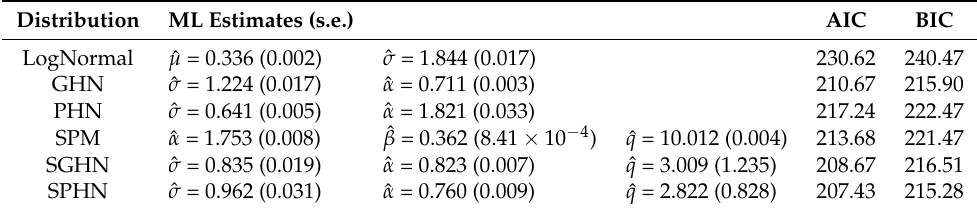
Table 7. Data set of survival times of guinea pigs.